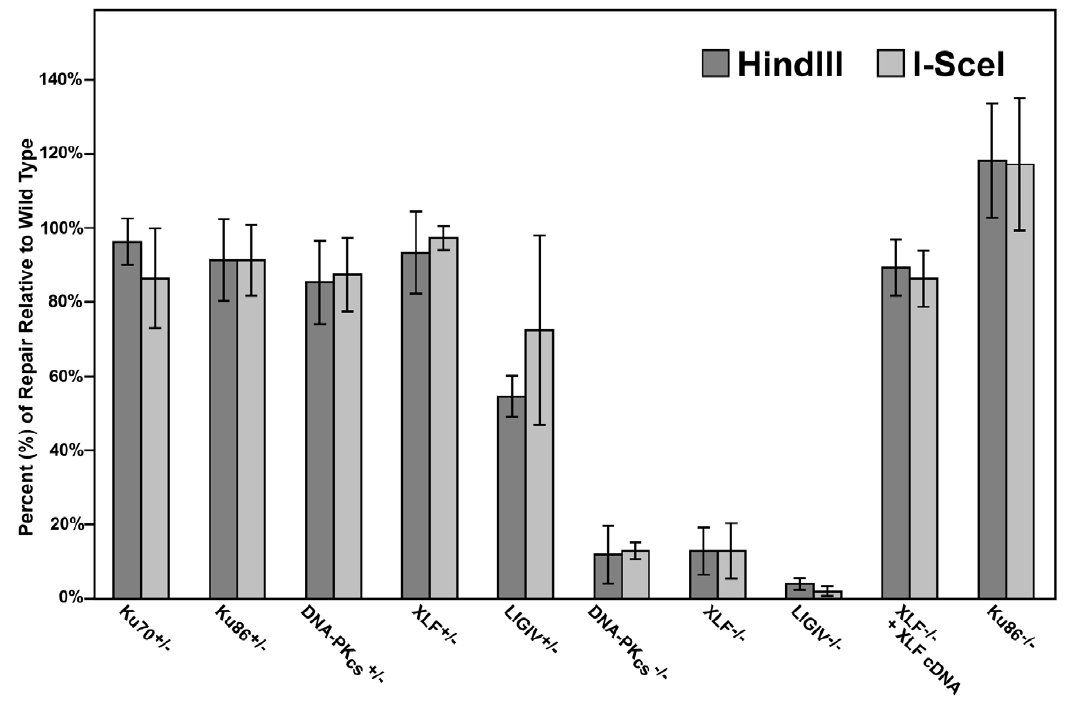
Figure 2. The impact of C-NHEJ mutations on end joining. Four independent experiments comparable to those depicted in Figure S1 and Figure 4 were performed and the average percent repair relative to wild-type is shown with the standard deviation.